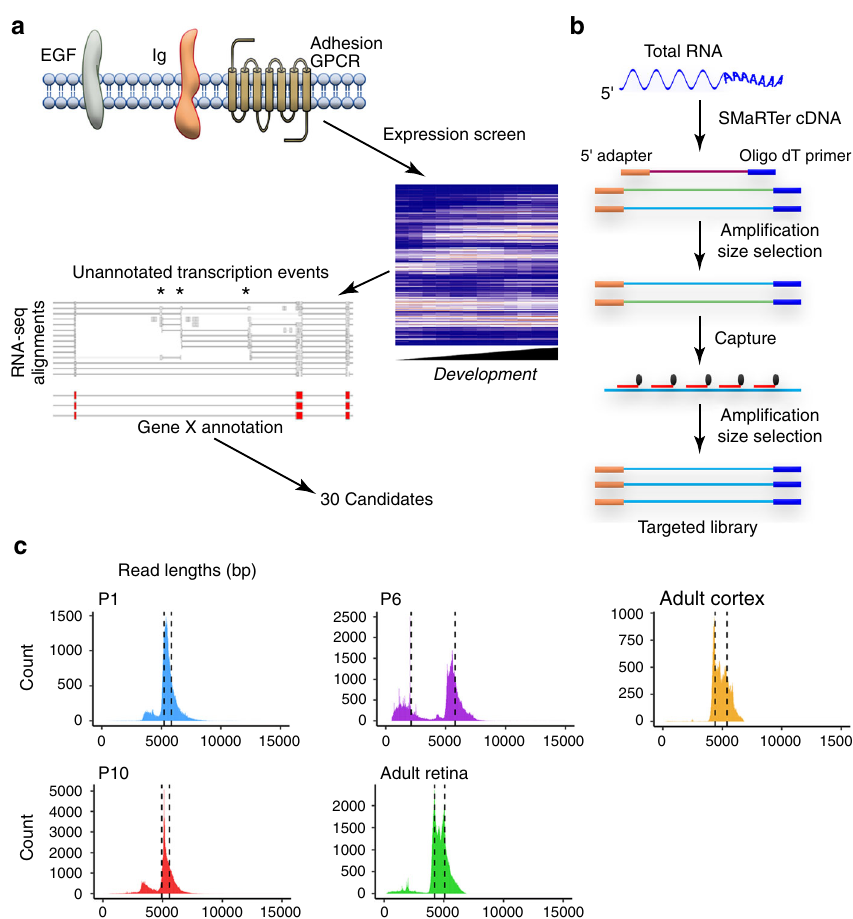
Fig. 1 Strategy for identifying cell surface receptors that exhibit high isoform diversity. a Screening strategy for selecting genes for lrCaptureSeq. Members of EGF, Ig, and adhesion GPCR families were tested for (1) expression during neural development, using RNA-seq data from retina and cortex; and (2) unannotated transcript diversity, based on RNA-seq read alignments to the UCSC Genes public database, which revealed use of unannotated exons, transcriptional start sites, and alternative splice sites. Thirty genes showing strong evidence for unannotated events (asterisks) were selected for targeted sequencing of full length transcripts ( b , c ). b lrCaptureSeq work fl ow. cDNAs are 5 ′ tagged to enable identi fi cation of full-length reads. Red, biotinylated capture probes tiling known exons. To obtain sequencing libraries enriched for intact cDNAs, two rounds of ampli fi cation and size selection were used. c Size distribution of full-length reads for each lrCaptureSeq experiment. Mouse retina or cortex transcripts were analyzed at the speci fi ed ages; adult mice were P35. The vast majority of reads are within expected size range for cDNAs of targeted genes. Dashed lines, quartiles of read length